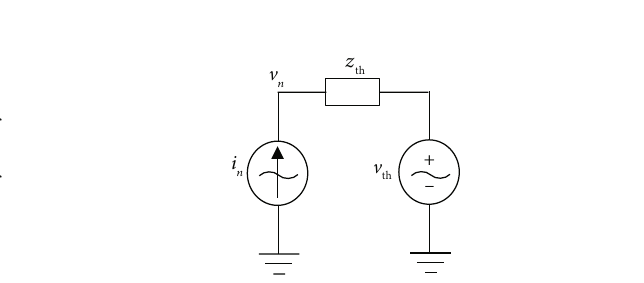
Figure 5: Simpli fi ed